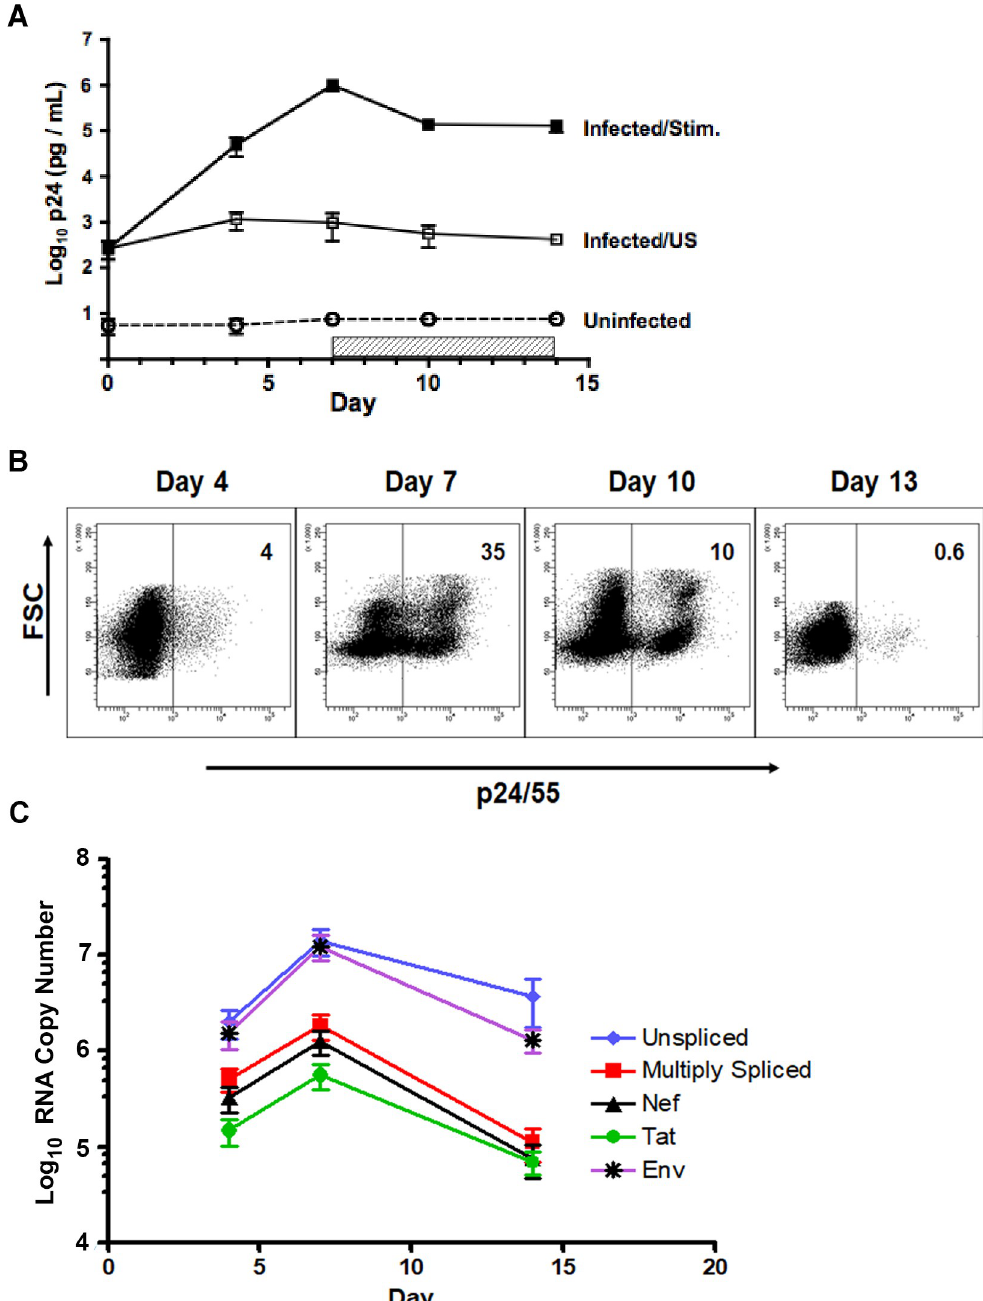
Fig 2. Kinetics of HIV replication induced during in vitro cell culture. (A) Productive HIV replication was analyzed in parallel with the induction of cell proliferation (Fig 1B). The NL4-3 infected CD4 T cells (Infected/Stim) and uninfected control cells (Uninfected) were stimulated and maintained in culture for 14 days, according to the experimental design shown in Fig 1A. The horizontal hatched bar indicates the addition of antiretroviral Indinavir (HIV protease inhibitor) to culture (days 7–14). A separate portion of infected cells was maintained in culture medium alone, without the addition of stimulating agents, cytokines or Indinavir (Infected/US). Aliquots of culture supernatant were removed on days 4, 7, 10, 14; and assayed for levels of secreted p24 by ELISA. Results shown: cumulative mean ± SEM for 5 independent experiments (cells from same donors used for Fig 1B). (B) Representative experiment showing serial analysis of intracellular expression of HIV Gag (p24/55) in a culture of infected, TCR-stimulated CD4 T cells; Indinavir added on day 7. Results depicted by flow cytometry dot plots of forward scatter, FSC (cell size) versus intracellular Gag (ICp24/55) staining. The positive cursor was set according to the fluorescence threshold of the uninfected cell control, stained in parallel with anti-p24/55 antibody.